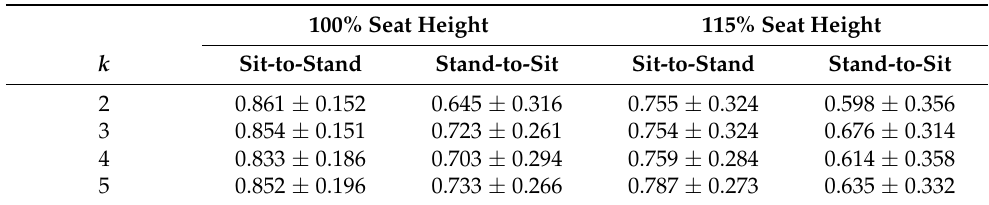
Table 3. Average R 2 with standard deviation values for different values of k when using age and BMI as k − NN